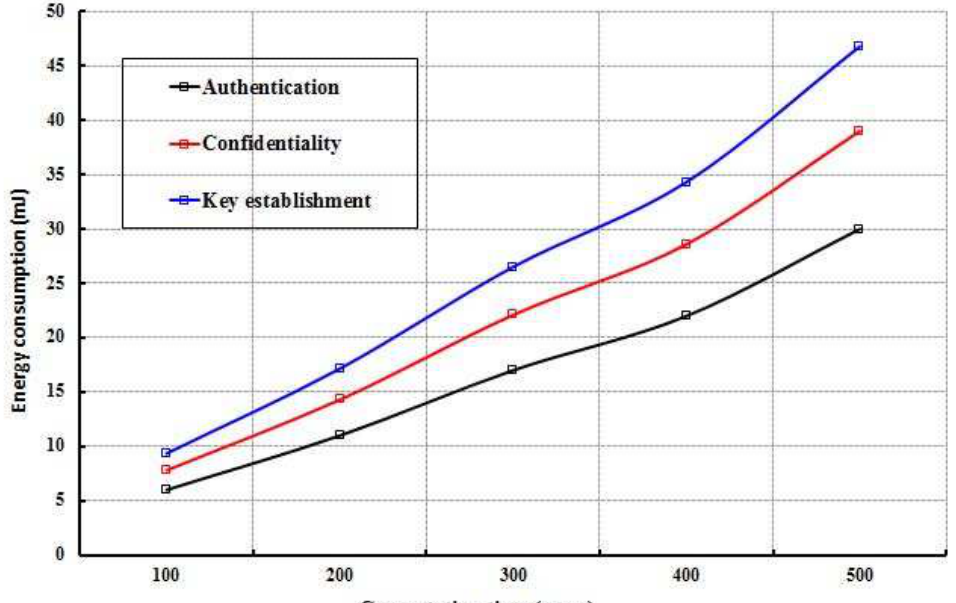
Figure 7. Evaluation of energy consumption with computation